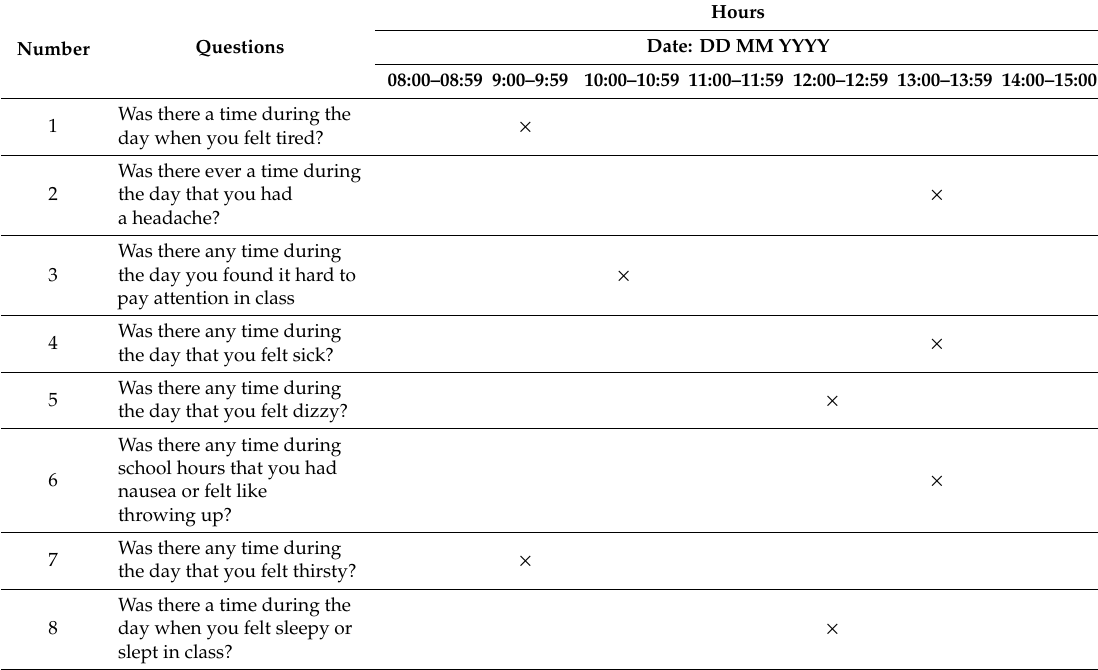
Table 2. An example of a completed Learner Symptom Questionnaire of how it will be completed daily.